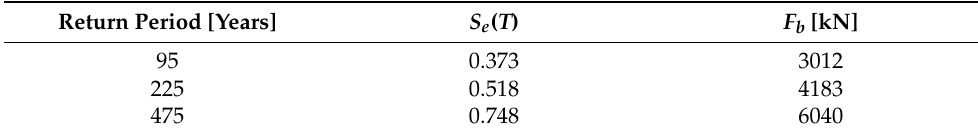
Table 3. Design spectrum and base shear forces for different return periods.